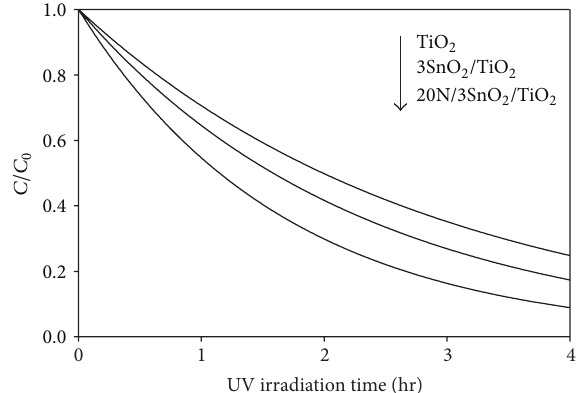
Figure 9: Photocatalytic degradation of MB in solution under UV excitation by various thin film coatings on glass fibers. The surface area of thin film available for reaction was held approximately constant, based on weight of glass fibers.